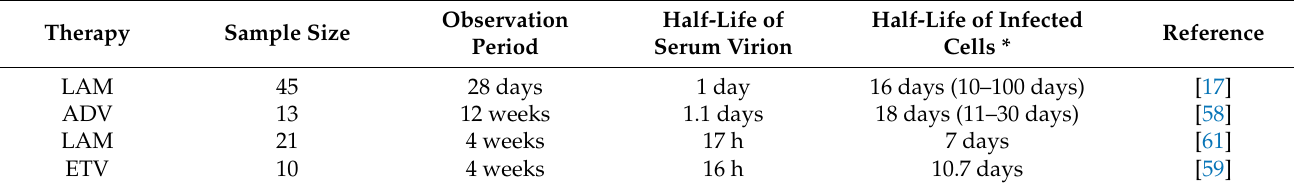
Table 1. cccDNA half-life during short-term NUC therapy.